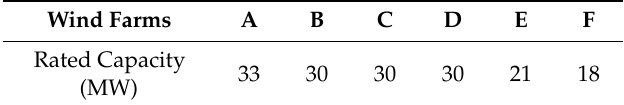
Table 3. Rated capacity of the six farms for the mode the power outputs. Wind Farms